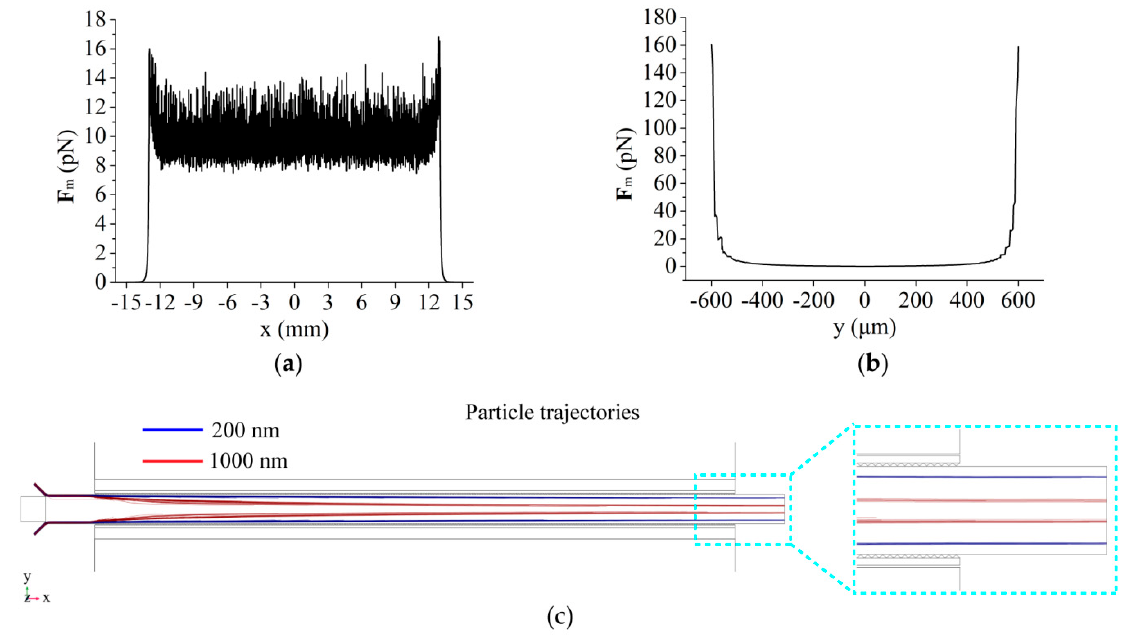
Figure 3. Calculated negative magnetophoretic force and particle trajectories based on the simulation results: ( a ) Negative magnetophoretic force acting on 1000 nm particles in the separation area along x -axis and ( b ) along y -axis; ( c ) The trajectories of 200 nm and 1000 nm particles in the simulation.